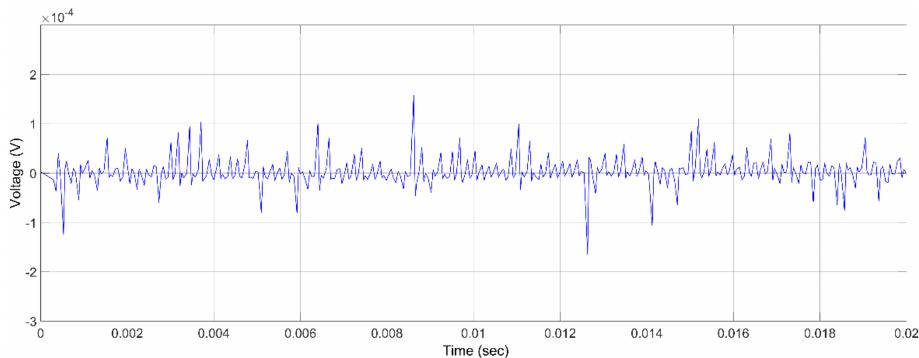
Figure 17. PD at 15 kV-Half